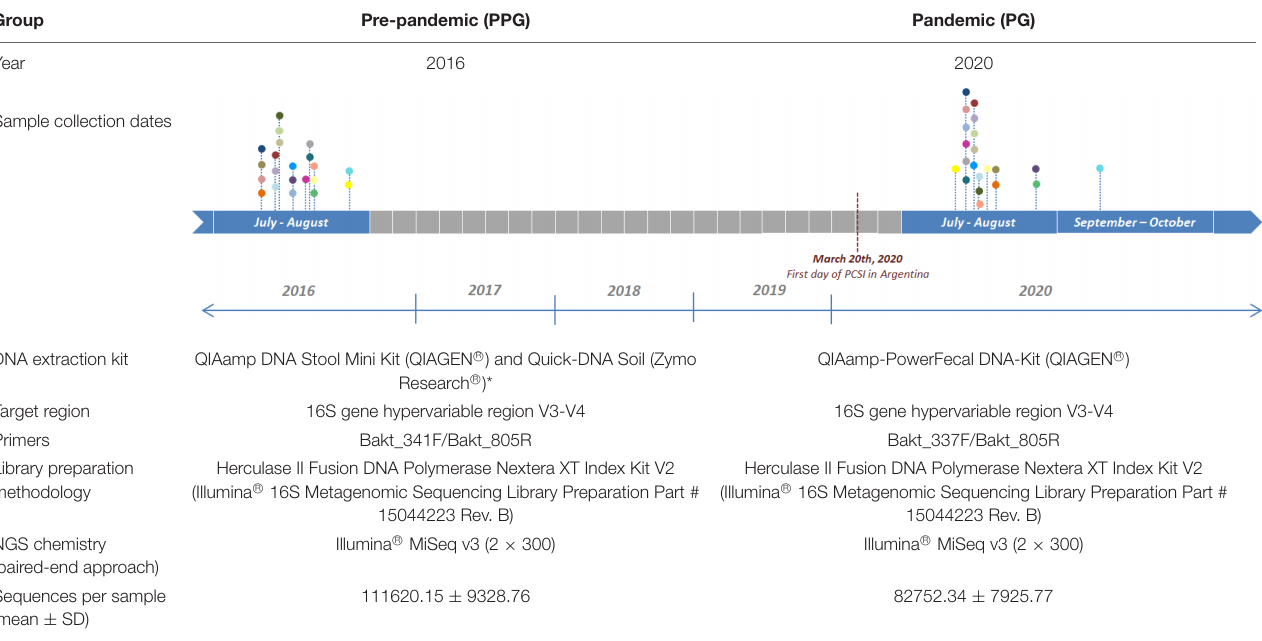
TABLE 1 | Comparison of sample collection dates, DNA extraction kits, library preparation and high-throughput sequencing methodologies for the PPG and PG analyzed in this